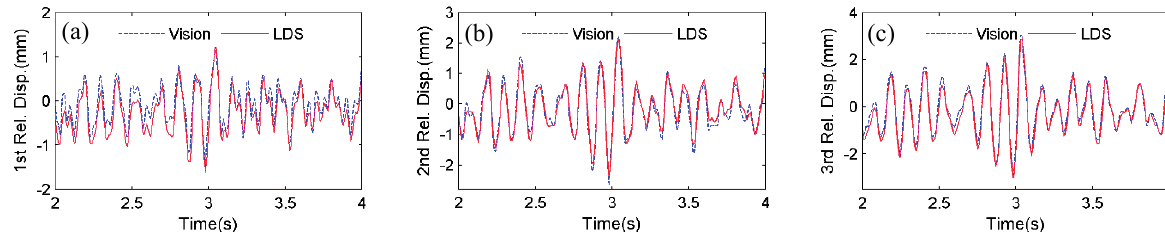
Figure 10. Comparisons of displacement relative to base floor between Vision (natural target) and LDS: ( a ) 1st floor; ( b ) 2nd floor; ( c ) 3rd floor.